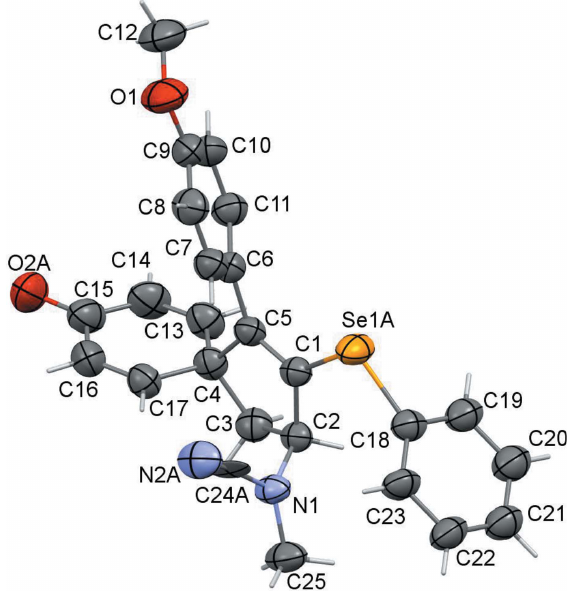
Figure 1 Molecular plot of title compound with ellipsoids drawn at 50% probability. Disordered portions are omitted for